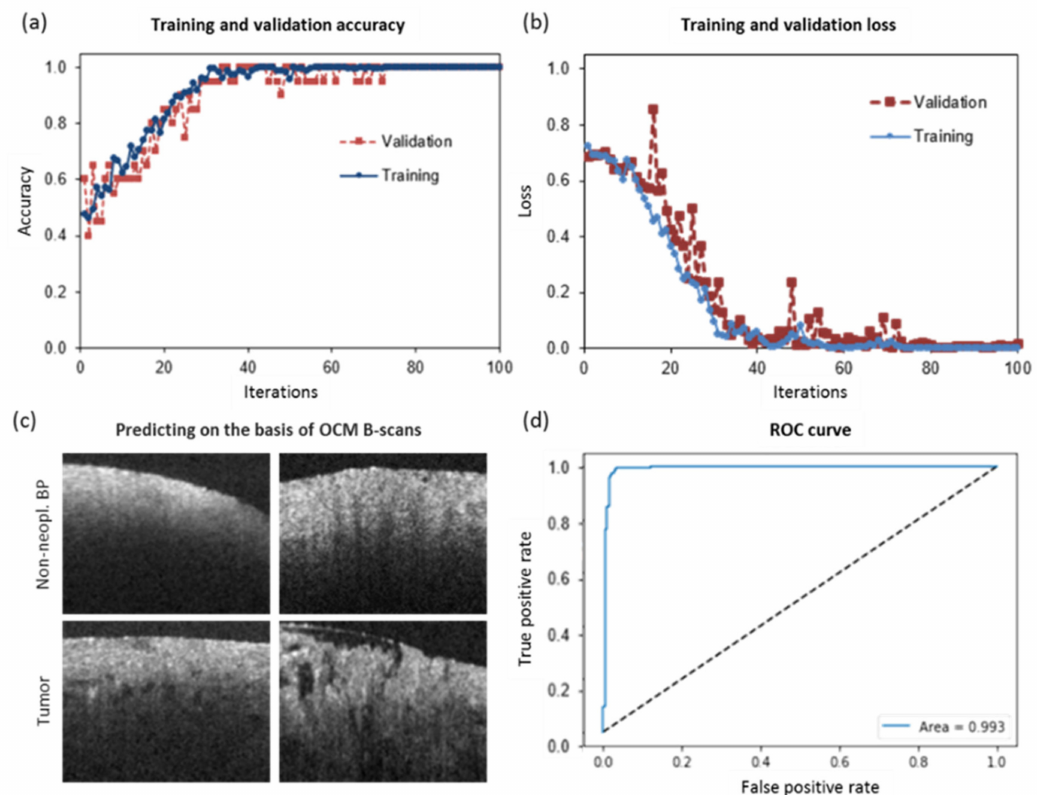
Figure 4. CNN (convolutional neural network)-based prediction of tumor versus non-neoplastic brain parenchyma. ( a ) Accuracy of training and validation processes over 100 iterations. ( b ) Loss during training and validation processes over 100 iterations. ( c ) Examples of OCM cross-sections of non-neoplastic brain parenchyma (Non-neopl. BP) versus tumor core. ( d ) ROC curve and area under the curve (AUC) of the CNN.